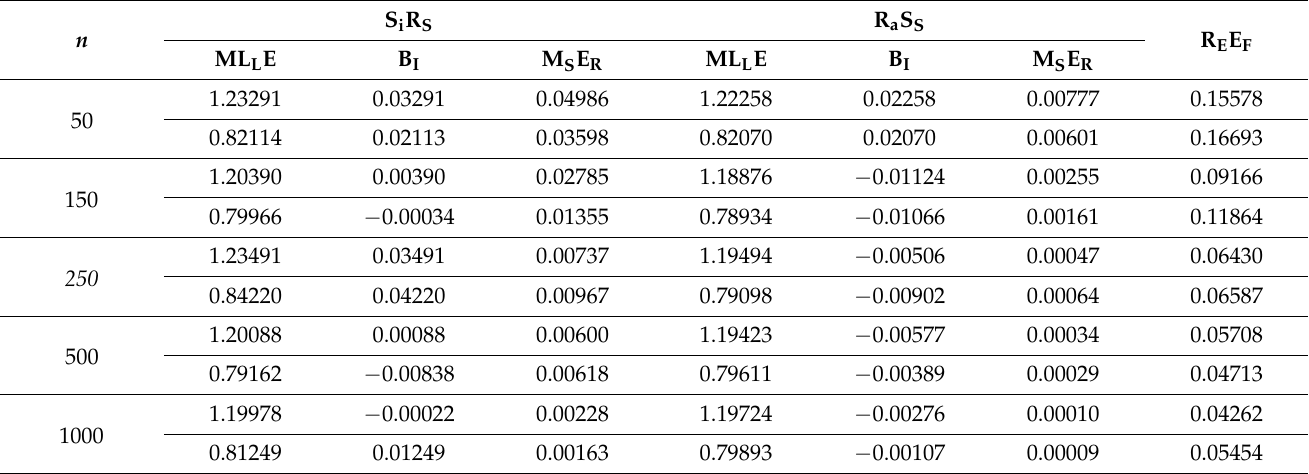
Table 3. The ML L E s , B I s, M S E R , and R E E F of the KMB X model under S i R S and R a S S at α = 1.2, β = 0.8.